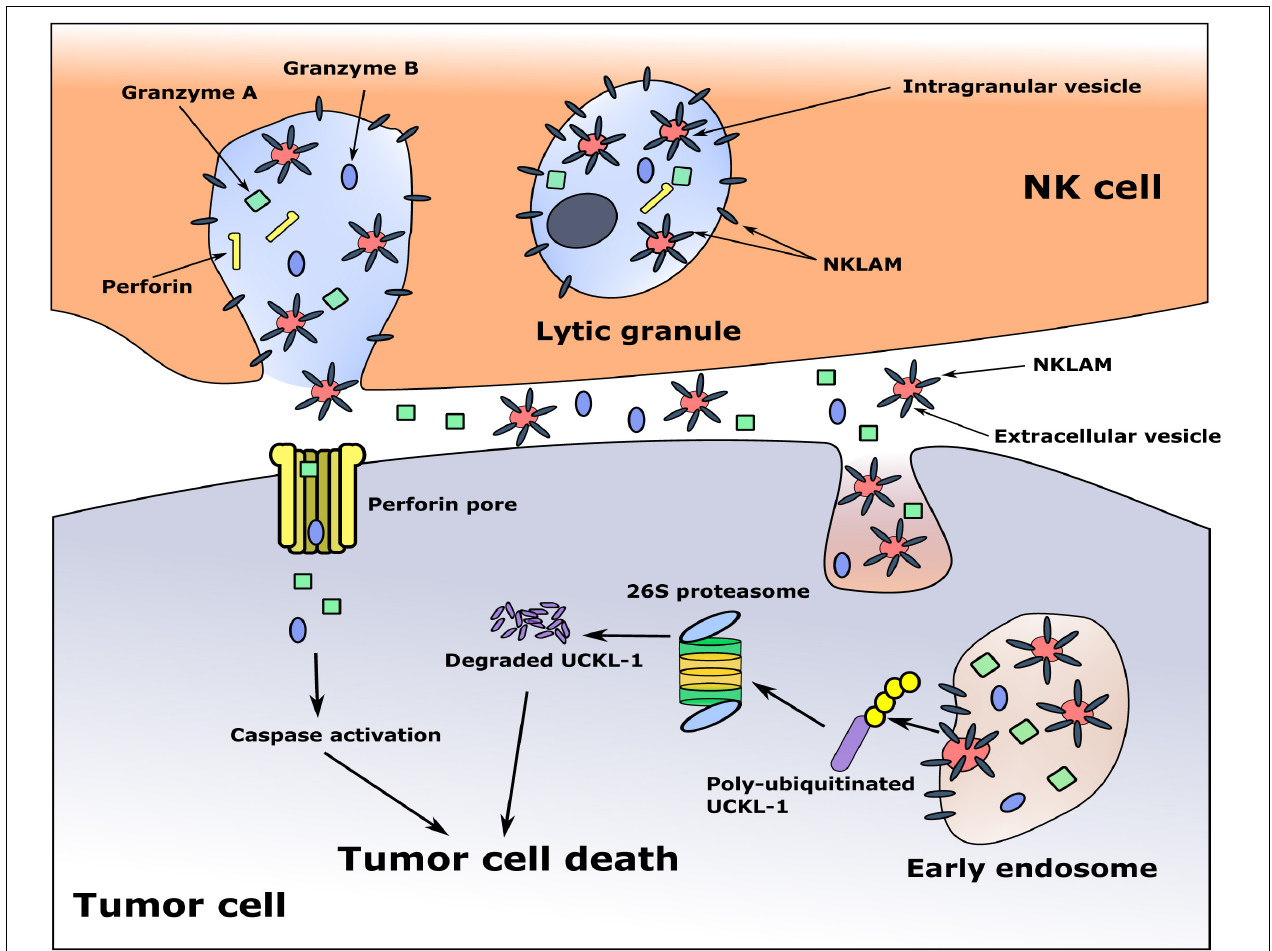
FIGURE 3 | Proposed model of NKLAM function in NK cells. The cytolytic granules of resting NK cells contain little to no NKLAM. Upon cytokine exposure or target stimulation, activated NK cells rapidly transcribe and translate NKLAM, which is embedded in cytolytic granule membranes. Smaller, intragranular vesicles also have NKLAM in their membranes. NK-tumor interaction releases granule contents (perforin, granzymes) into the tumor cell at the immunological synapse. Intragranular vesicles are also released; these now called extracellular vesicles (EVs) contain NKLAM, as well as perforin and granzymes, and enter the tumor cell by endocytosis. Granzymes induce caspase activation; NKLAM ubiquitinates and degrades the tumor survival protein UCKL-1. This combination of perforin, granzymes, and NKLAM ensures death of the tumor cell. Red circles: EVs; gray bars: NKLAM; green squares, blue ovals: cytolytic proteins granzymes A and B; yellow bars: perforin; purple bar: UCKL-1; yellow circles: